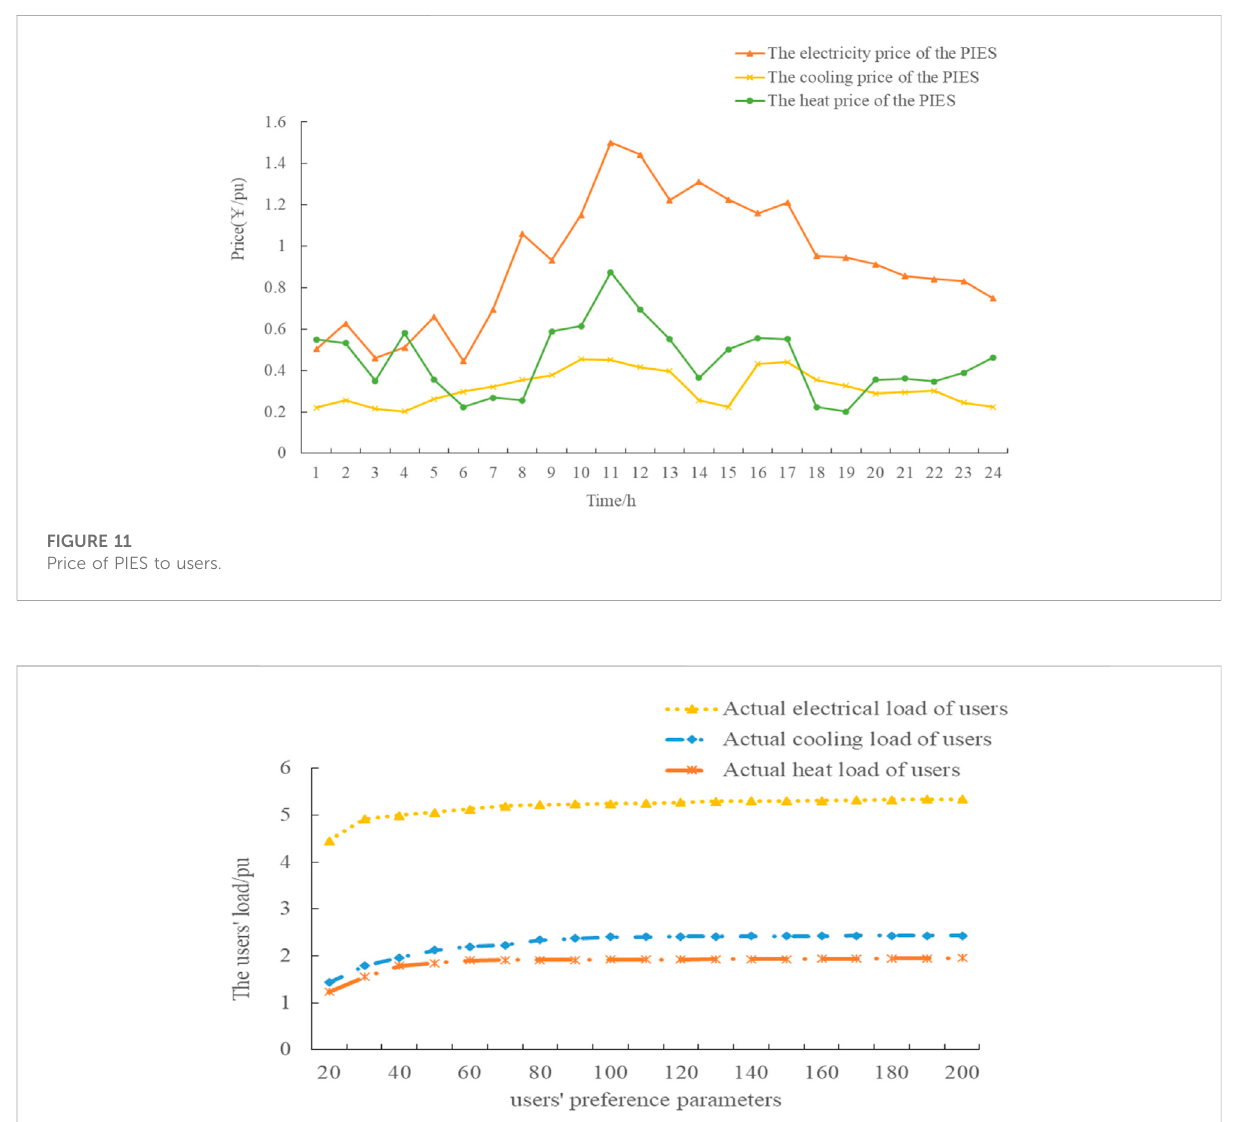
FIGURE 12 In fl uence of users ’ preference parameters on game results.